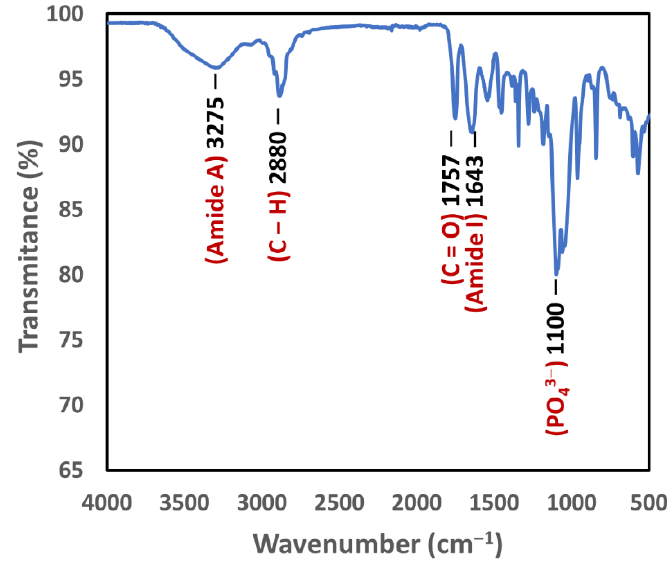
Figure 5. FTIR spectrum of a 3D bioplotted scaffold showing the presence of PLGA (carbonyl group) as well as collagen (amide A and amide I) and hydroxyapatite (PO 43 − ions).